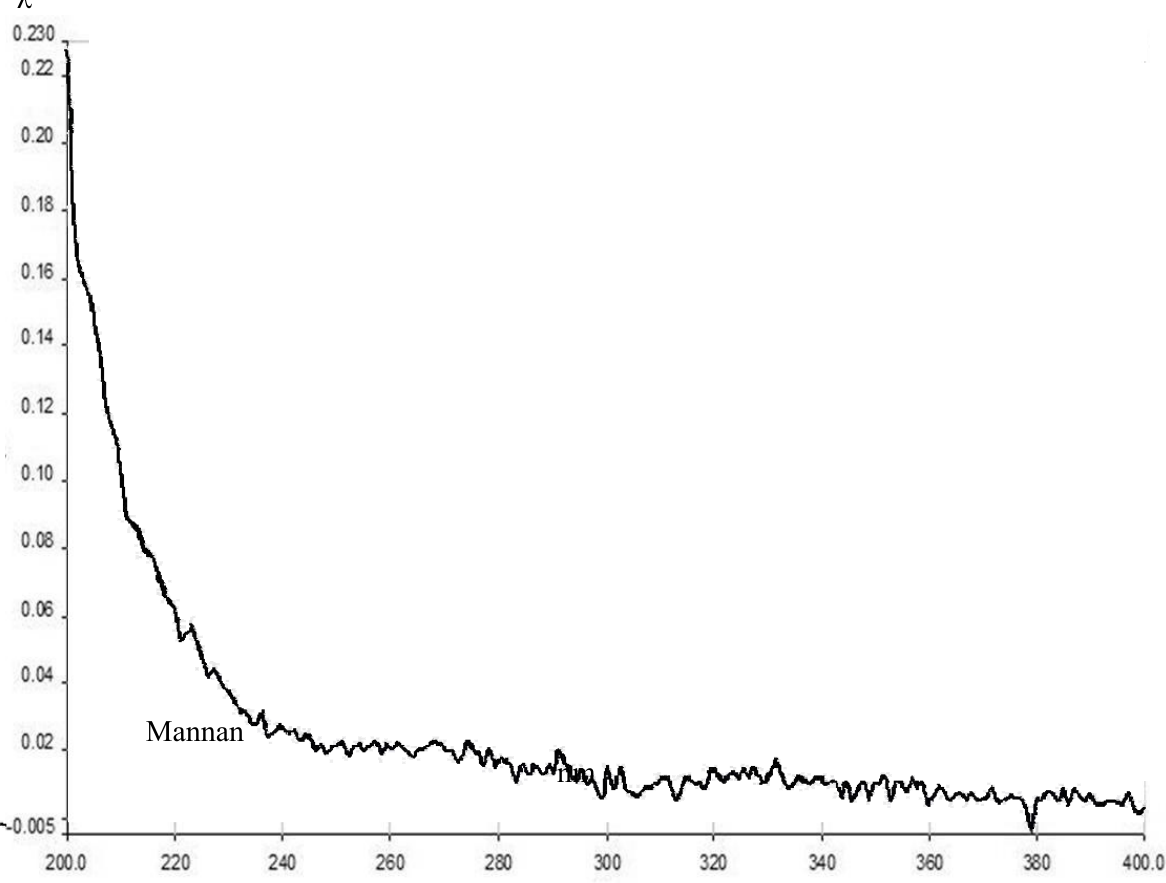
Figure 3. UV spectrum of the crystals formed by Man. The λ values in the ordinate vary from 0.005 to 0.230. No peaks were found in the